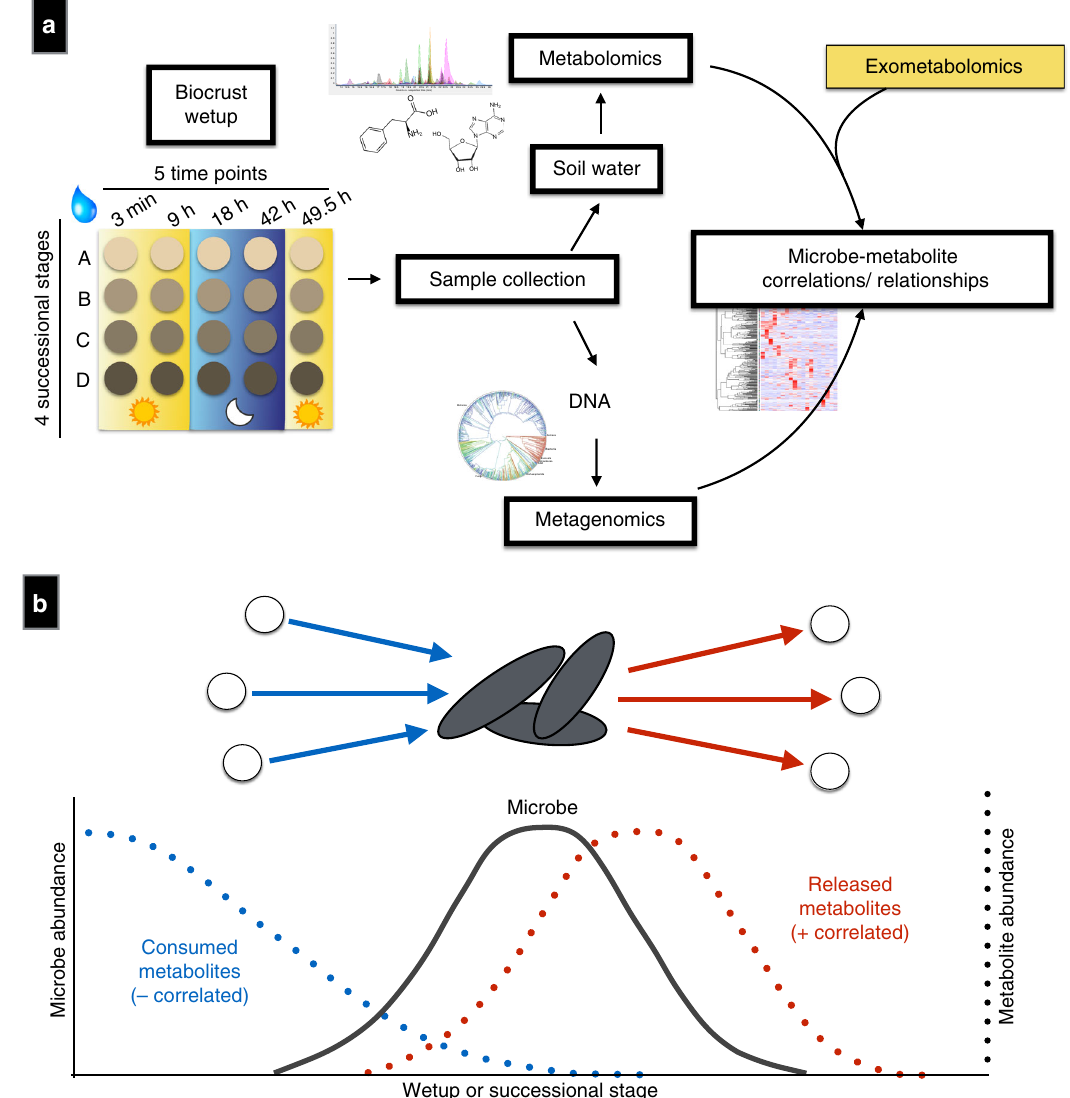
Fig. 1 Experimental work fl ow and biocrust microbe – metabolite relationship predictions. a Biocrust wetup metabolomics and metagenomics experimental setup and analysis. To study microbe – metabolite relationships in situ, biocrusts from four successional stages were wetup and sampled at fi ve time points (total n = 100). Biocrust soil water was removed and analyzed by liquid chromatography/ mass spectrometry ( n = 5 for each group) and biocrust DNA was extracted for shotgun sequencing ( n = 1 for each group). Metagenome-estimated genome and metabolite abundances were analyzed through Spearman rank correlations to determine microbe – metabolite relationships and compared to the expected relationships based on isolate exometabolomic studies. b Exometabolomics-based in situ microbe – metabolite relationship prediction. The hypothesis is that isolate exometabolomics can be used to predict microbe – metabolite patterns in situ based on microbial abundance: Across wetting and successional stages, microbes change in abundance and negatively correlate with metabolites that they consume and positively correlate with metabolites that they release (metabolites are indicated by dotted